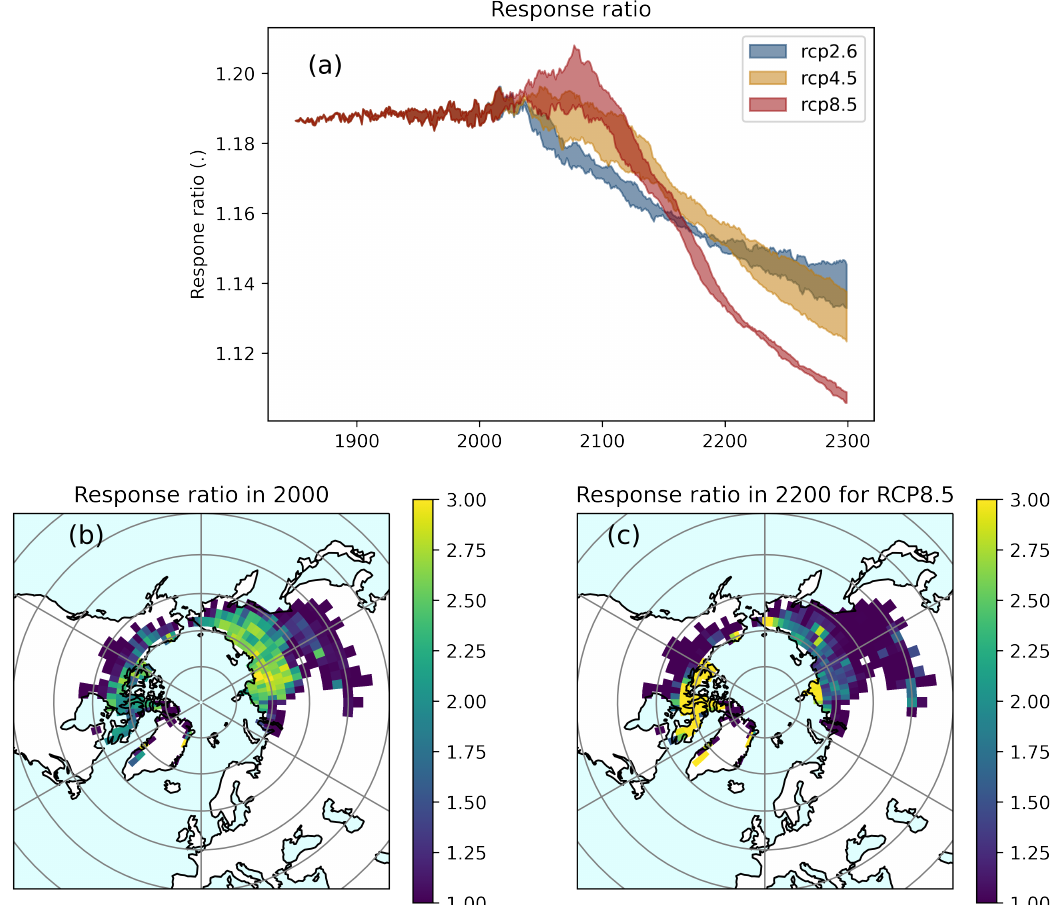
Figure 6. ( a ) The time series of the annual and ensemble mean response ratio (the ratio of the potential amount of C that can be allocated to growth and spreading of the vegetation compared with the actual amount achieved in the natural state calculated from the area-total fluxes) for the CN spun configuration and transient-ens simulation over the permafrost region. The spatial distribution of the response ratio for ( b ) the year 2000 and ( c ) the year 2200. A higher response ratio reflects more N limitation and a lower response ratio means less N limitation. A response ratio of 1 means no N